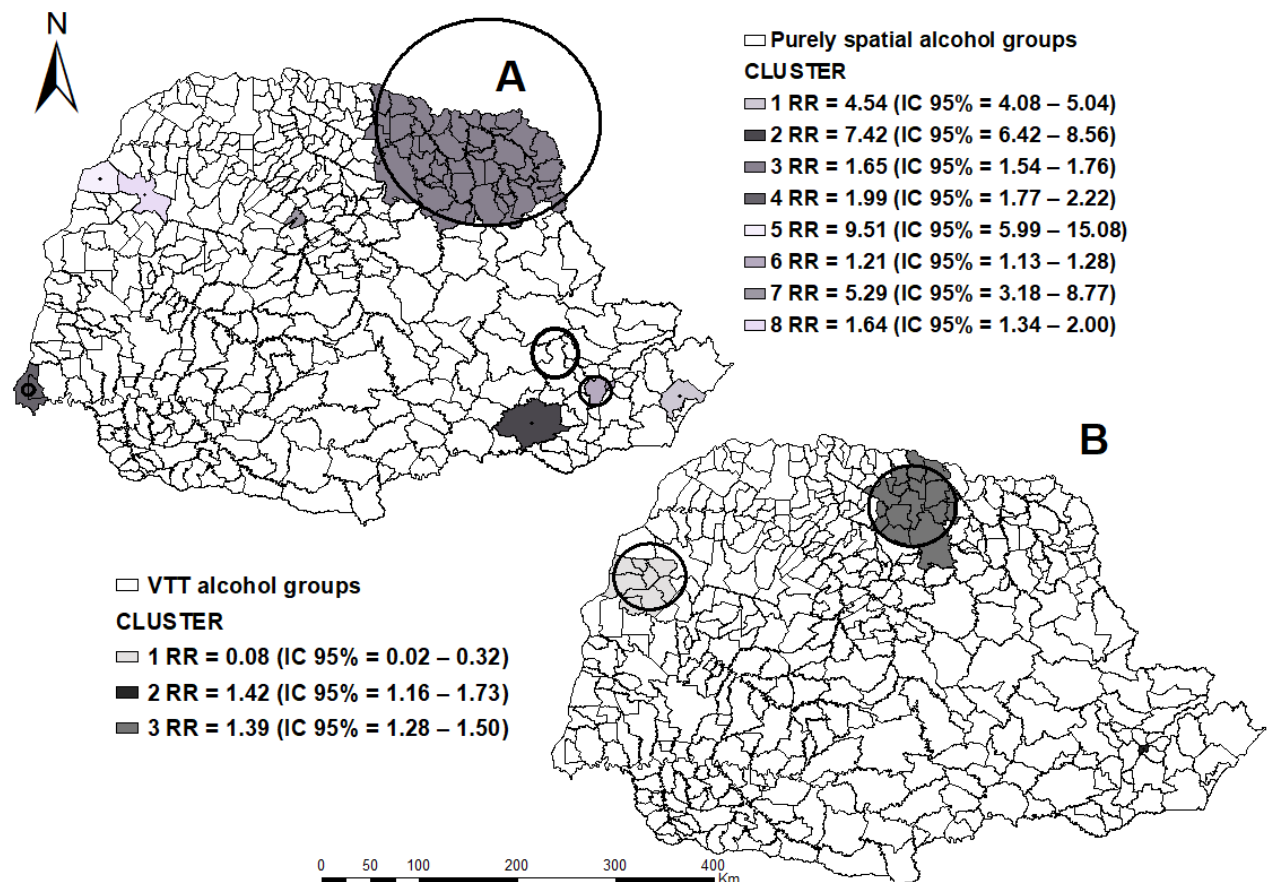
Figure 2. Areas of spatial risk for tuberculosis in alcohol users, by municipalities, state of Paraná (2008–2018). ( A ) applied the purely spatial technique; ( B ) applied the purely Spatial Variation in Temporal Trends. Legend: ArcGIS [GIS software]. Version 10.0. Redlands, Califórnia, EUA: Environmental Systems Research Institute, Inc., 2010.